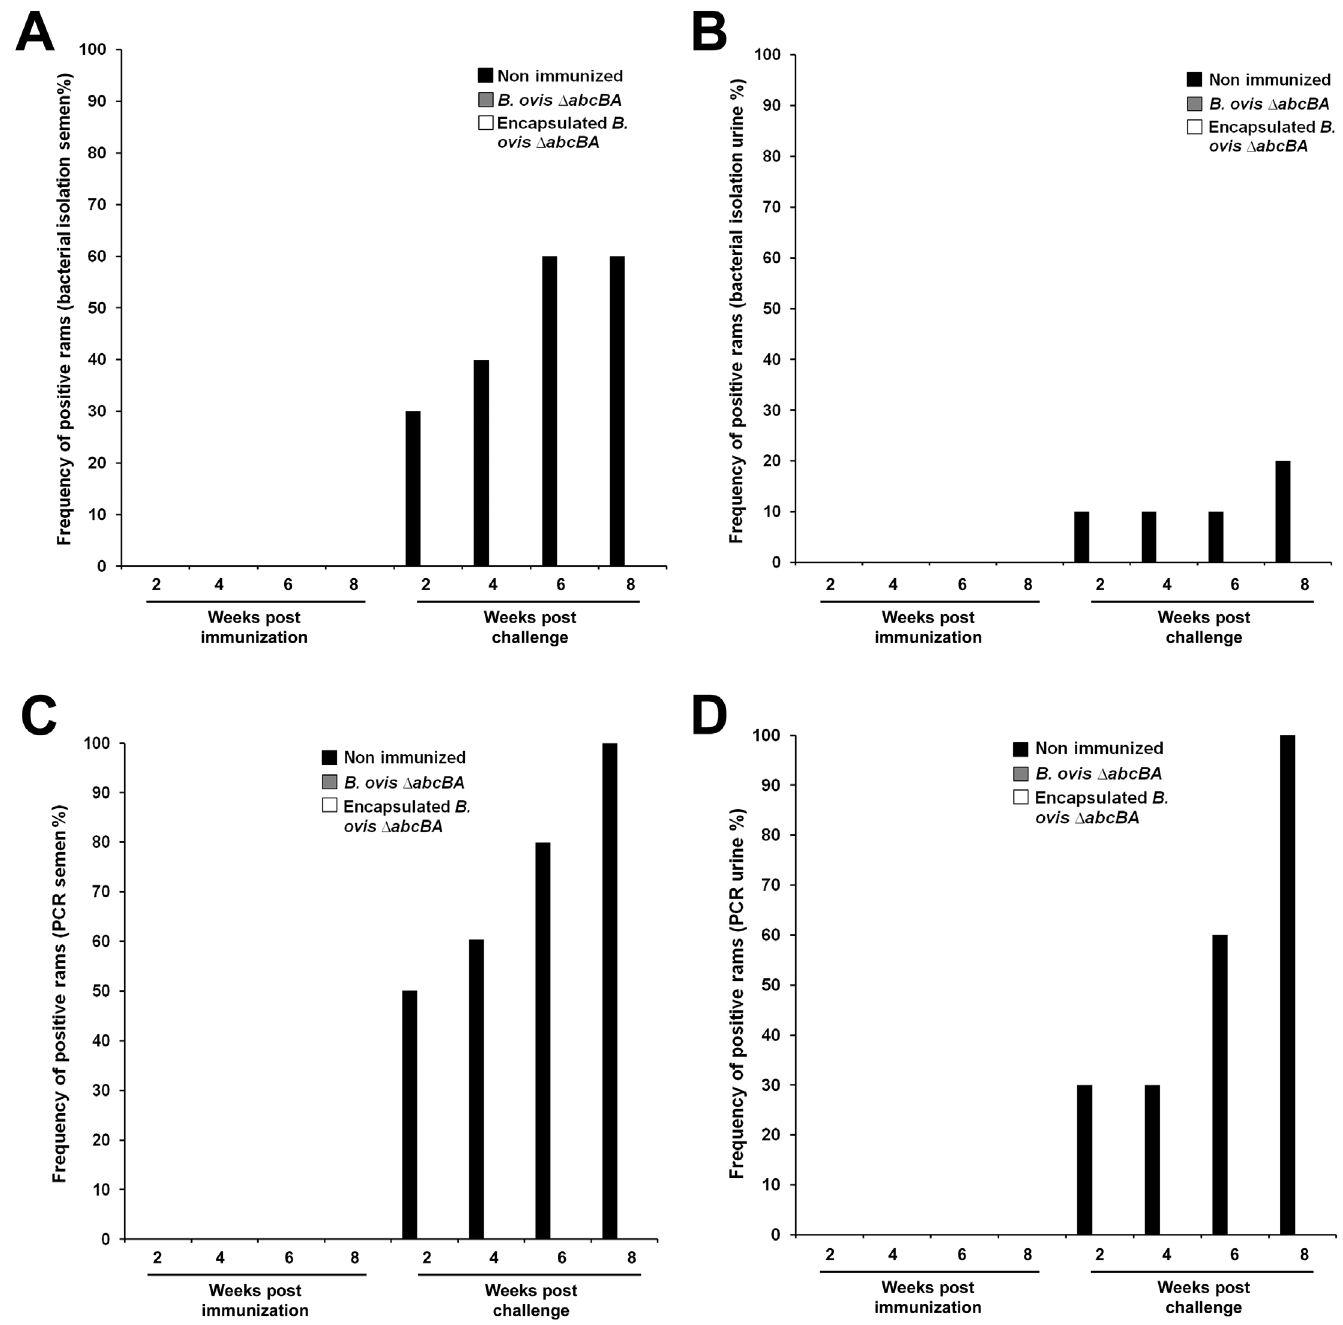
Fig 5. Frequency of isolation of wild type Brucella ovis from semen (A) and urine (B); or PCR detection in semen (C) or urine (D) samples, before and after challenge. The number of weeks is indicated in the x